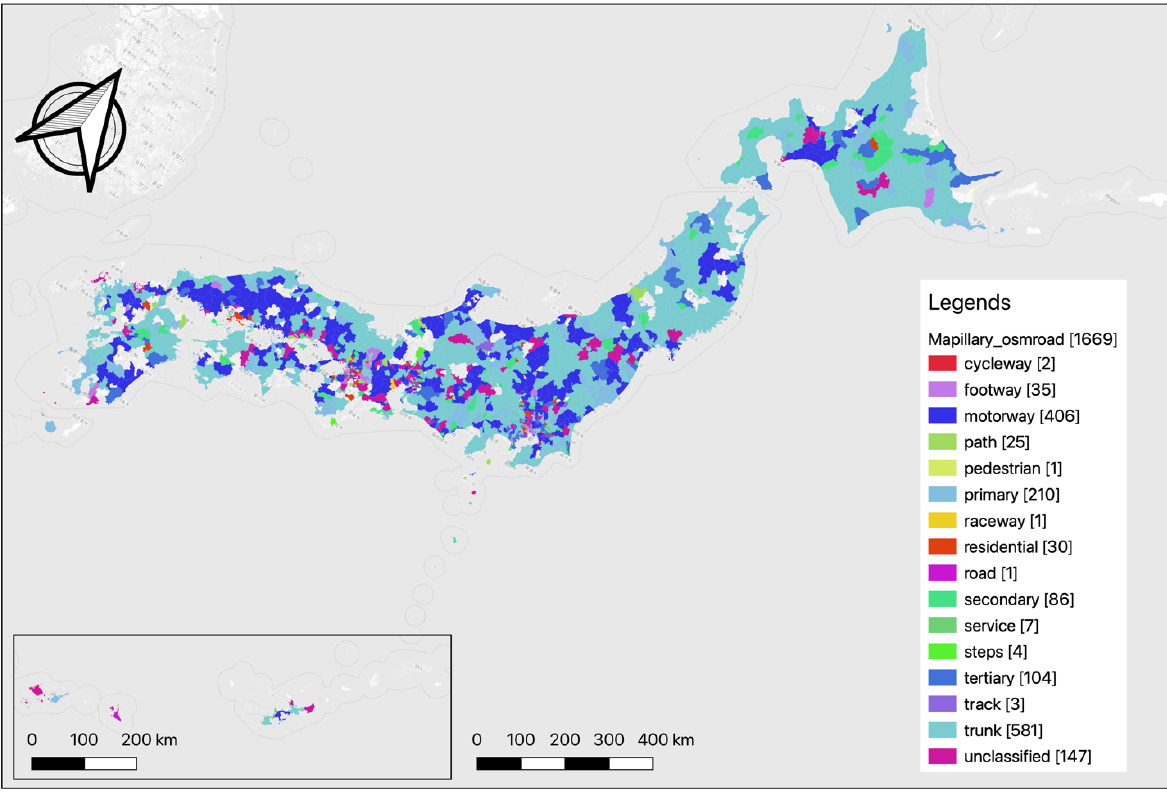
Figure 9. Most common road classifications in terms of Mapillary points of interest (unit: number of